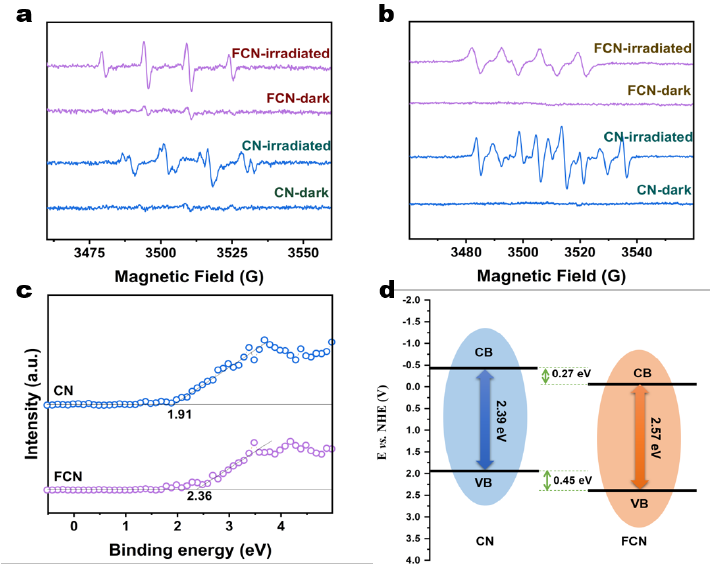
Figure 6. ( a ) ESR spectra of CN and FCN in darkness and under visible-light irradiation to evaluate the generation of ·O 2 − radicals ( b ) ESR spectra of CN and FCN in the dark and under visible- light irradiation to evaluate the generation of ·OH- radicals. ( c ) VB-XPS spectra of CN and FCN. ( d ) Schematic of the band structures of CN and FCN.